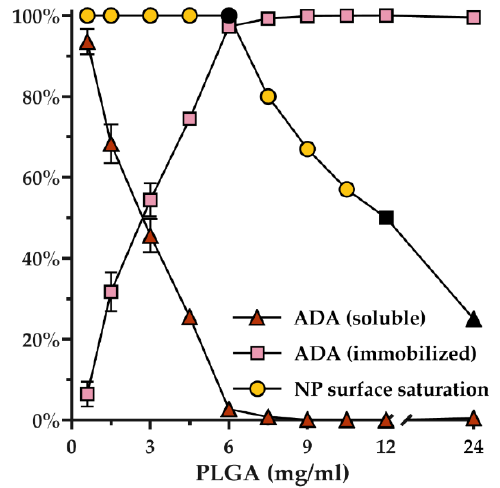
Figure 2. Coupling efficiency of adalimumab (ADA) on blank nanoparticles (NP) using EDC as a crosslinker. Different PLGA concentrations resulted in nanoparticles with surface saturation rates of 100% (●, ADA-NP), 50% ( ■ , ADA-NP50) and 25% ( ▲ , ADA-NP25). Values are calculated by quantifying the excess of soluble ADA in supernatant after centrifugation at 21,000× g for 30 min following EDC crosslinking. Data are shown as mean ± SD ( n = 3).